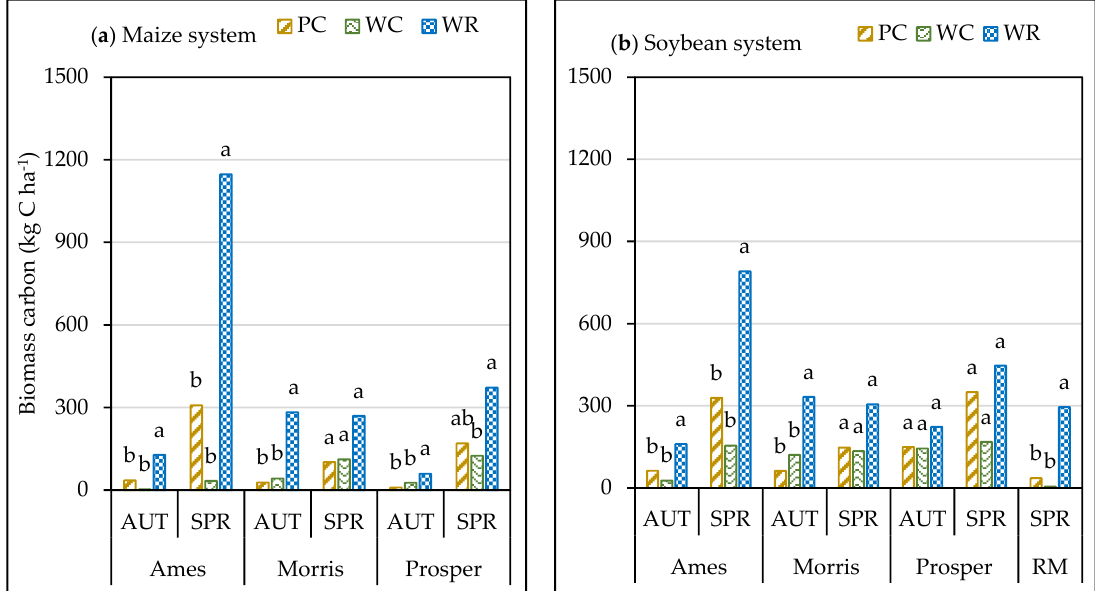
Figure 5. Mean carbon accumulation (kg C ha − 1 ) in the di ff erent cover-crop (PC = pennycress, WC = winter camelina, and WR = winter rye) biomass in autumn (AUT) and spring (SPR) at Ames, Morris, Prosper, and RM (Rosemount) when cover crops were interseeded in standing ( a ) maize and ( b ) soybean. Means with same letter within a location and a season for the same system were statistically same. Data for maize system and in autumn for soybean system at Rosemount (RM) are not available.